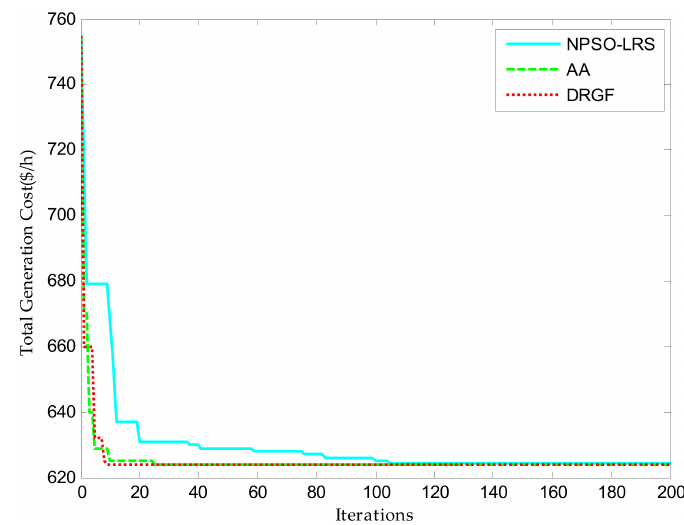
Figure 4. Optimization curves of 10 units test system. AA: auction-based algorithm.